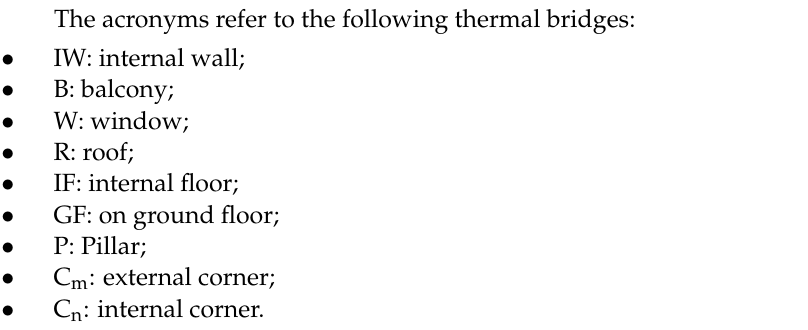
Figure A1. Schematic representation of thermal bridges in a building envelope.